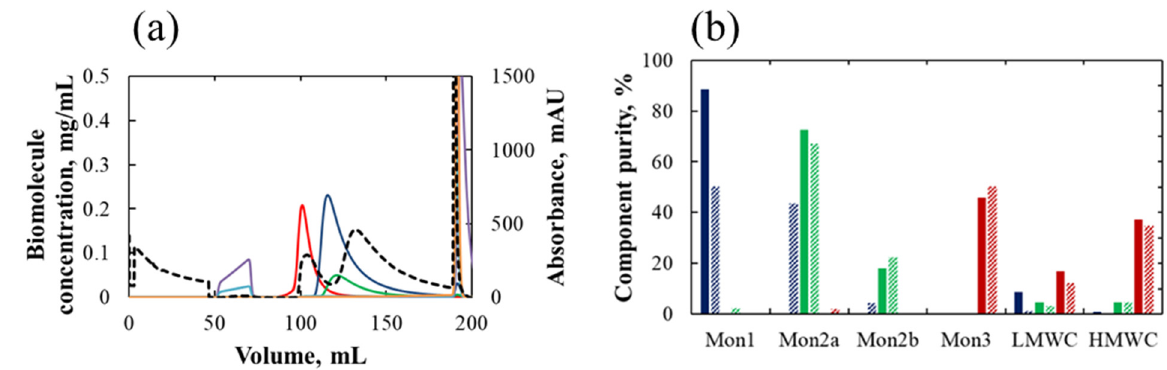
Figure 13. ( a ) Results of the validation run performed for the industrial in-development process; line colors as in Figure 11. ( b ) Comparison of experimental (full bars) and simulated (dashed bars) purities of the different components in the three elution peaks of the validation run. Blue, green, and red bars refer, respectively, to Peak 1, Peak 2, and Peak 3.